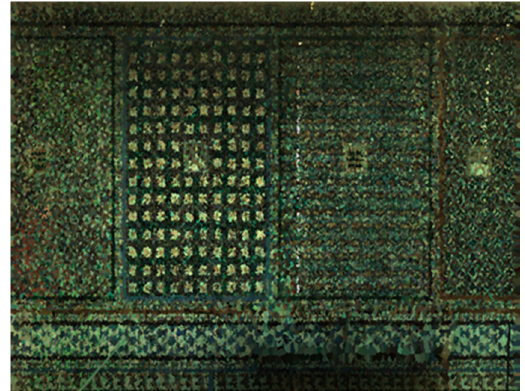
Figure 17. High-resolution texture